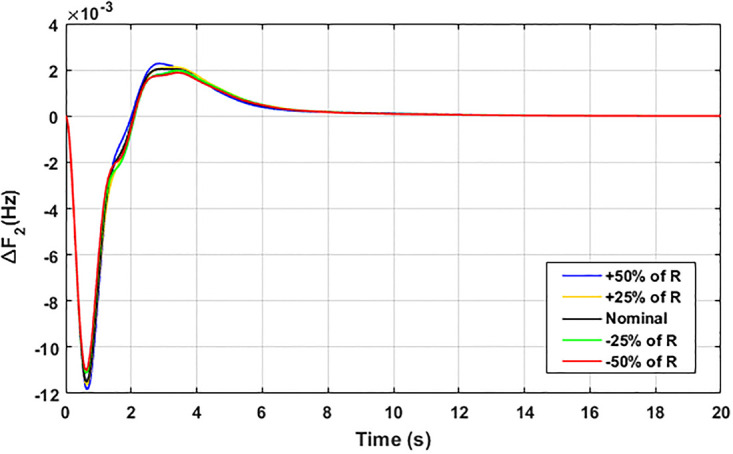
Results for variation in R with ΔF2.